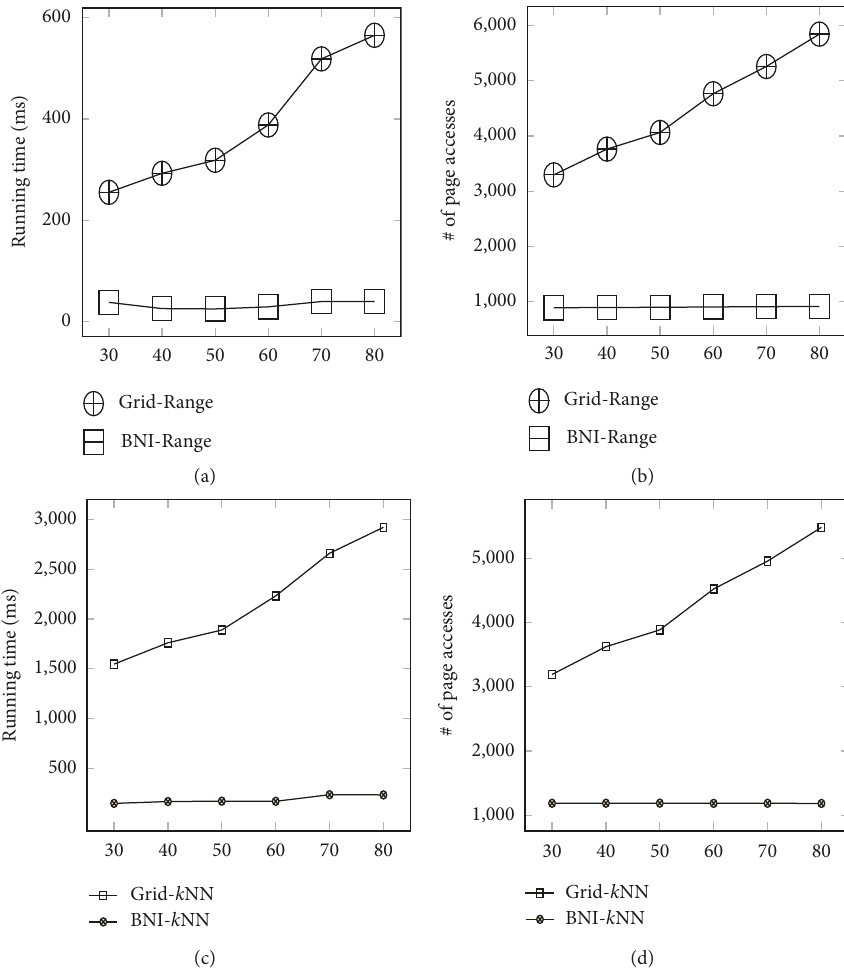
Figure 14: Effect of parameter